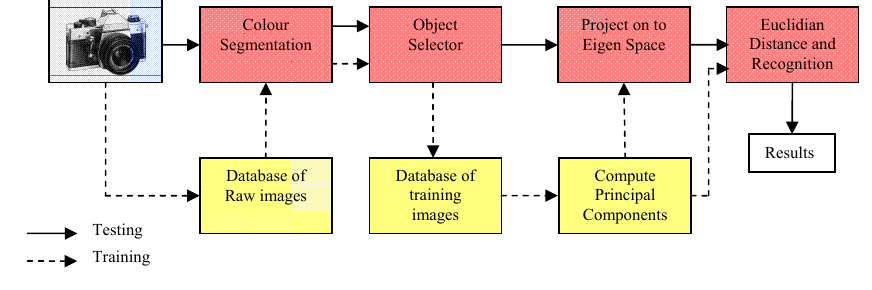
Figure 2. Block diagram of the proposed